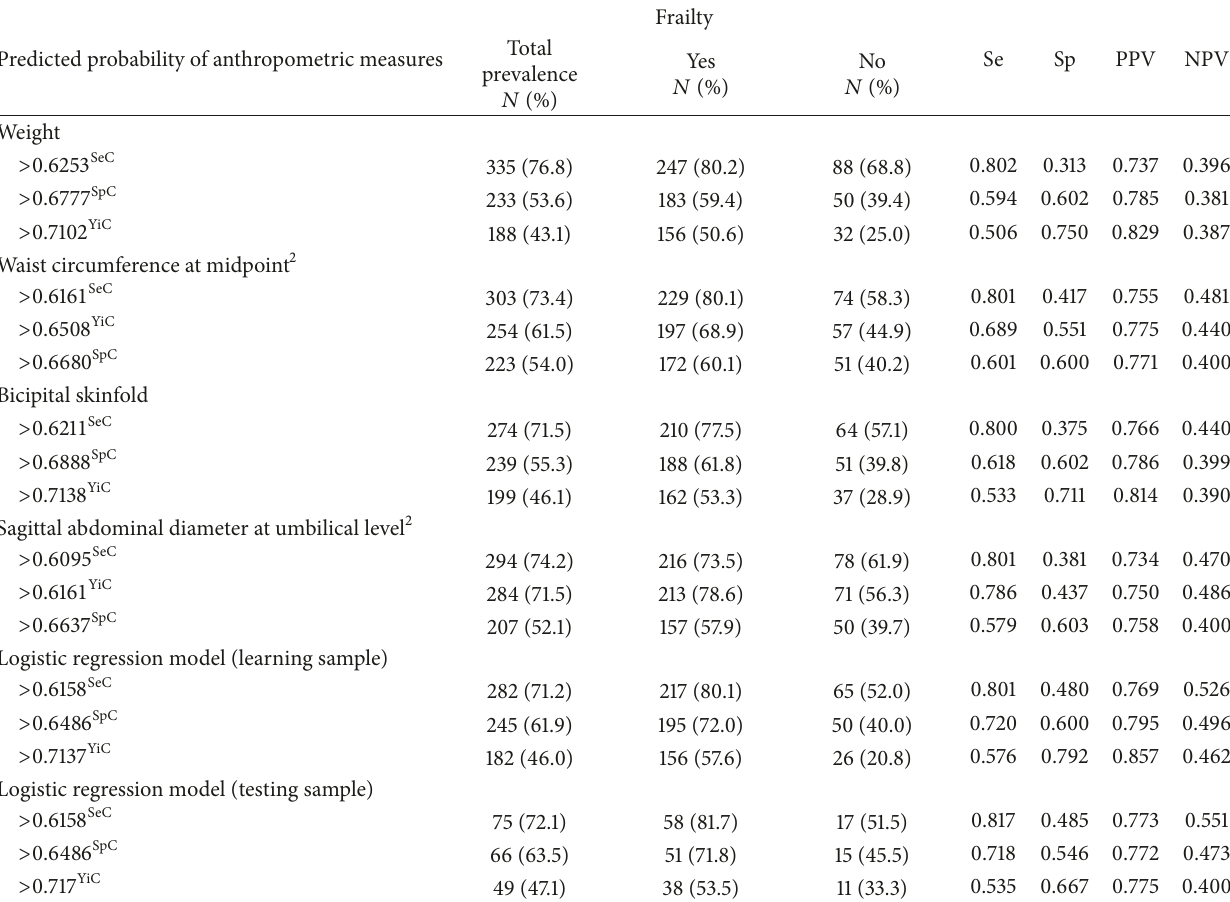
Table 3: Prognostic ability of anthropometric measures as predictors of prefrailty + frailty in older adults who were assisted at primary health care centers.